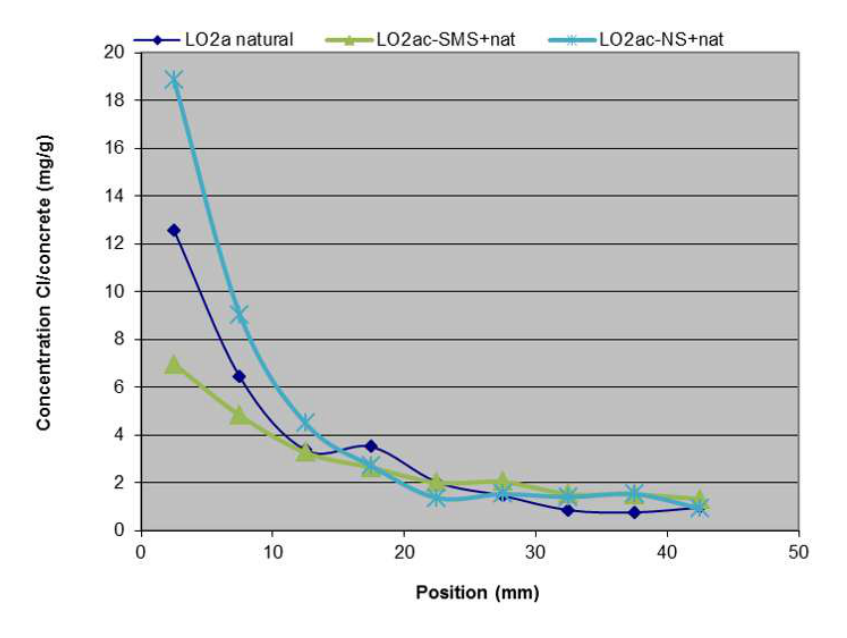
Figure 5. Concentration of chloride ions Low quality concrete, Natural diffusion.